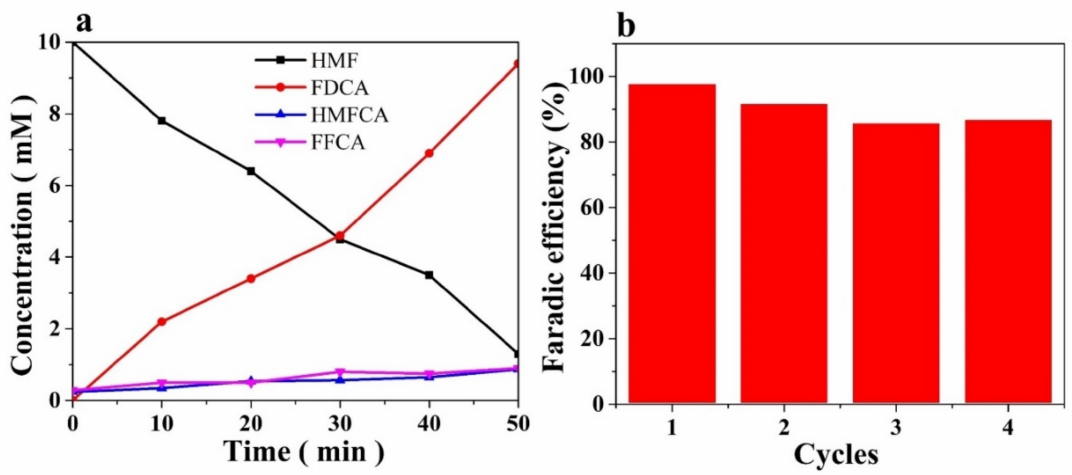
Figure 5. ( a ) LC chromatogram traces of the various products at different reaction times following an HMF electrochemical oxidation reaction with the flow rate of 0.2 mL/min. ( b ) Faradic efficiency CoB/g-C 3 N 4 @NiF with 10 mM HMF in 1.0 M KOH solution for four consecutive